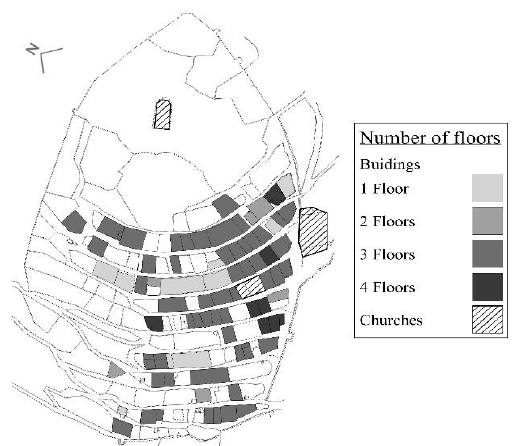
Figure 3. Distribution of the number of floors for each SU in Campi Alto di